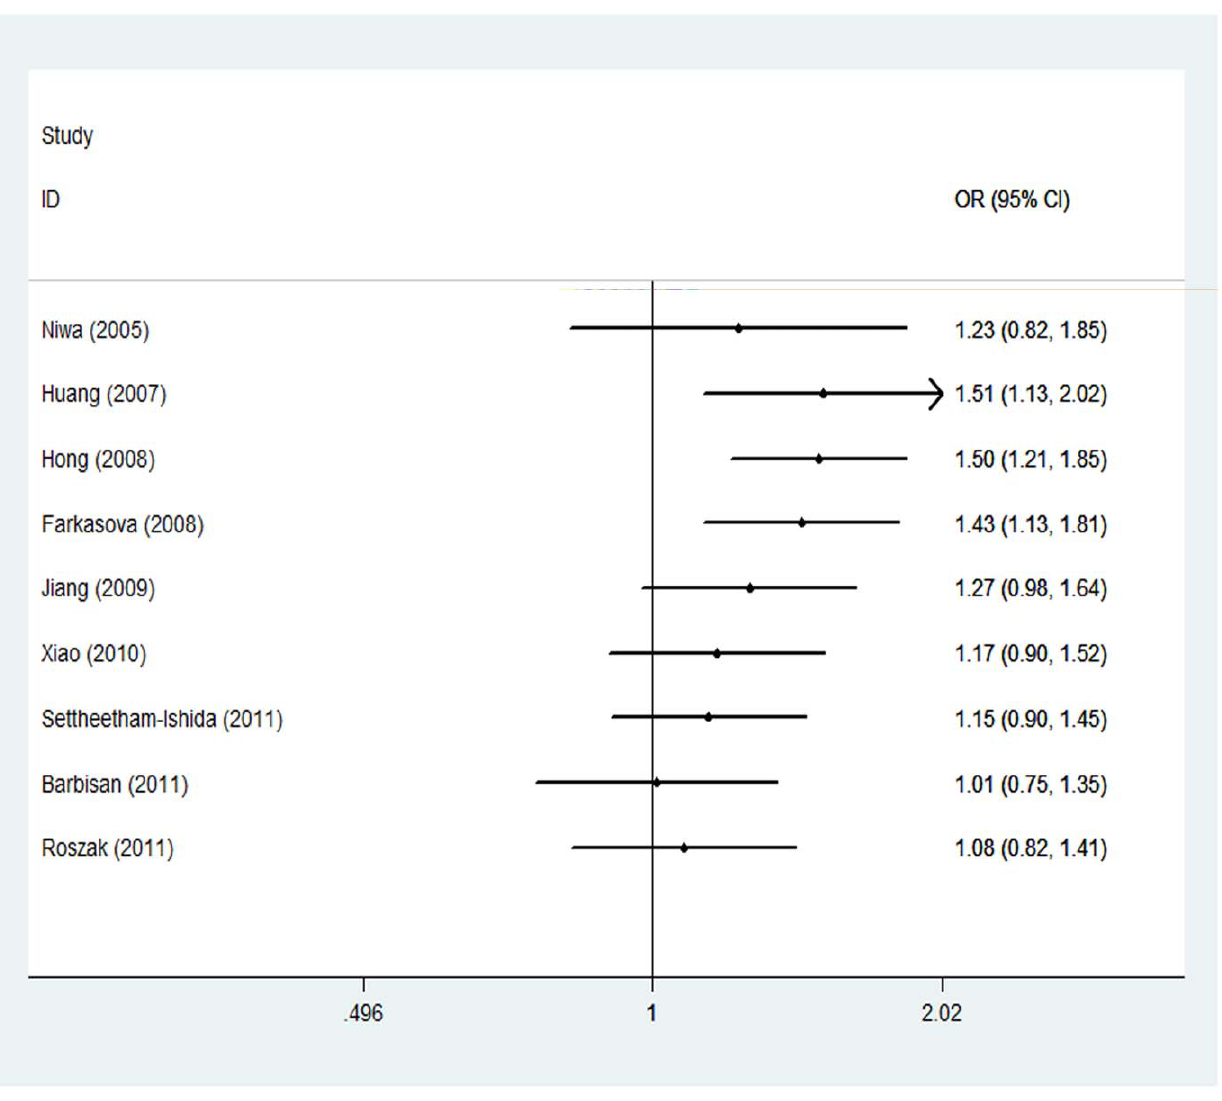
Figure 4. Results from cumulative meta-analysis of associations between x-ray repair cross-complementing group 1 gene (XRCC1) Arg399Gln GG-plus-GA genotypes (G carrier group), as compared with the AA genotype, and cervical cancer risk. The circles and horizontal lines show the accumulation of estimates as results from each study were added, rather than the estimate for each individual study. Studies sorted by publication time; Bars, 95% confidence interval.